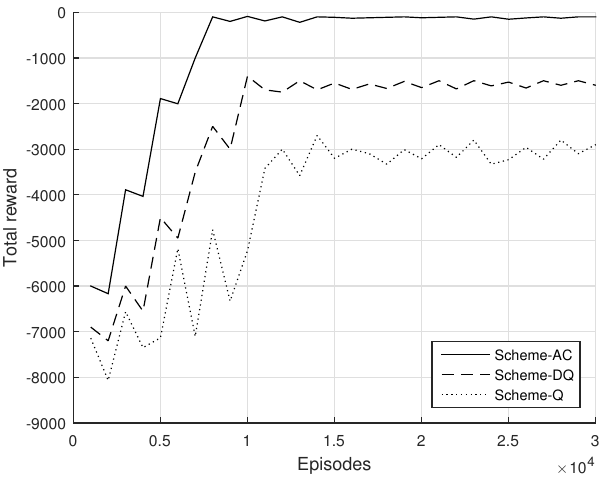
Figure 4. Convergence of the RL-based proposed solution